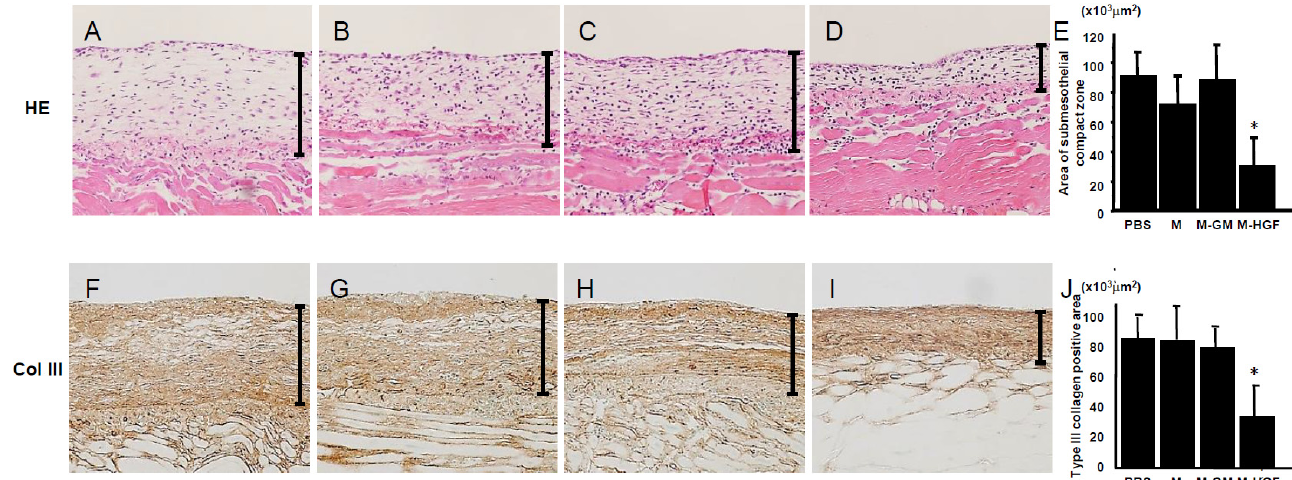
Figure 2. HE staining (upper panel) and immunohistochemistry findings for type III collagen (lower panel) of peritoneal tissues at day 21. In the PBS group ( A ), CG induced marked thickening of peritoneal tissue. In the M group ( B ) and M-GM group ( C ), marked thickening of the submesothelial compact zone was observed, similar to that found in the PBS group at 21 days. In the M-HGF group ( D ), progression of peritoneal thickening was suppressed at 21 days. ( E ) The bar graph shows the results of the semi-quantitative analyses of the submesothelial compact zone. In the PBS group ( F ), the expression of type III collagen markedly increased in the thickened submesothelial compact zone at 21 days. In the M ( G ) and M-GM ( H ) groups, the expression levels of type III collagen were greatly increased in the submesothelial compact zone at 21 days, similar to the PBS group. In the M-HGF group ( I ), type III collagen expression decreased in the submesothelial compact zone at 21 days. ( J ) The bar graph shows the results of the semi-quantitative analyses of type III collagen-positive areas. * denotes a significant difference compared with the PBS group at p < 0.05. Bars indicate the thickness of the submesothelial compact zone; magni fi cation, 200×. Table 1. The body weight and liver and renal functions in each group of mice. Data are expressed as mean ± standard deviation (SD). Phosphate-bu ff ered solution (PBS); CG injected mice adminis- tered PBS-CGMs, M; CG injected mice administered macrophages, M-GM; CG injected mice admin- istered macrophages phagocyting CGMs, M-HGF; CG injected mice administered macrophages phagocyting CGMs incorporating HGF gene. BW, body weight; AST, aspartate aminotransferase; ALT, alanine aminotransferase, BUN, blood urea nitrogen; Cr, creatinine.